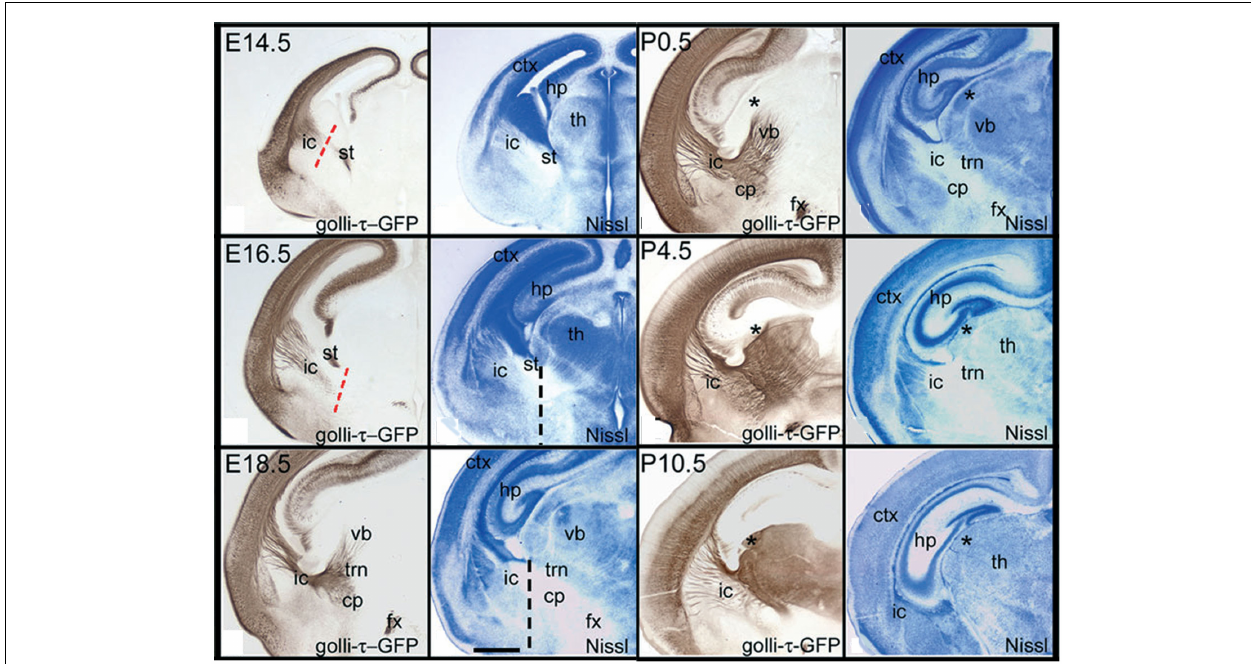
(labeledTRN in panels), which they reach by E18.5. Between P0 and P4 cortical axons innervate the midline nuclei, but they advance relatively slowly and some thalamic nuclei (e.g., dLGN – asterisk) do not get a substantial innervation until the end of the first postnatal week. dLGN, dorsal lateral geniculate nucleus; GP, globus pallidus; LGE, lateral ganglionic eminence; MD, mediodorsal nucleus; MGE, medial ganglionic eminence; PSPB, pallial–subpallial boundary; RTN, reticular thalamic nucleus; Stri, striatum;VB, ventrobasal